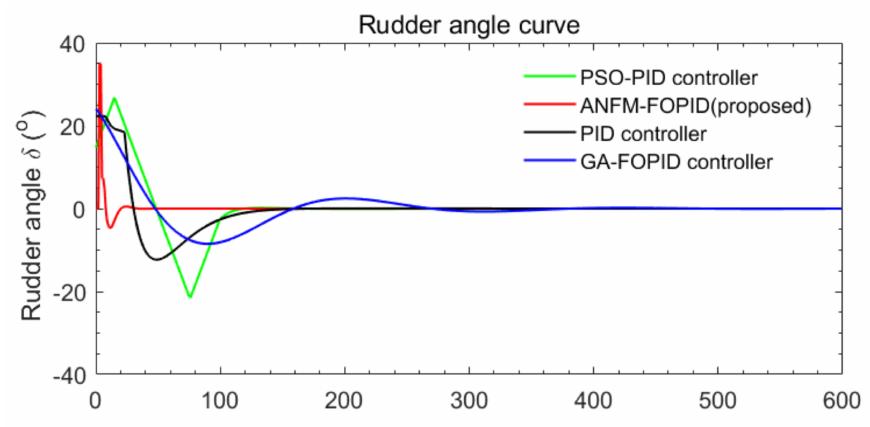
Figure 23. Comparison of rudder angle using four different